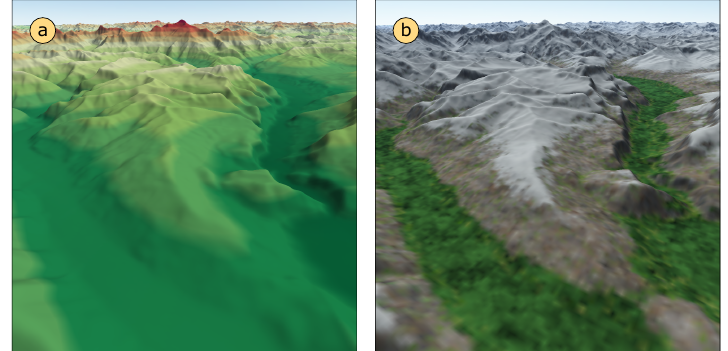
Figure 2. Visualizing terrain using textures. ( a ) uses color to encode the elevation of the terrain, while ( b ) uses a more natural